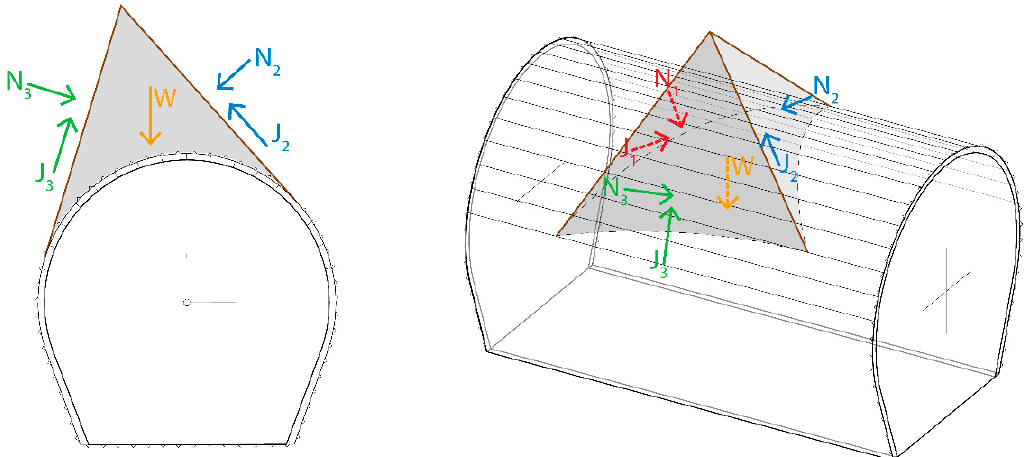
Figure 1. Example of a wedge in two and three dimensions around contour of underground excavation with forces acting on it. N i —normal component of force; J i —shear component of force; W—weight of wedge.